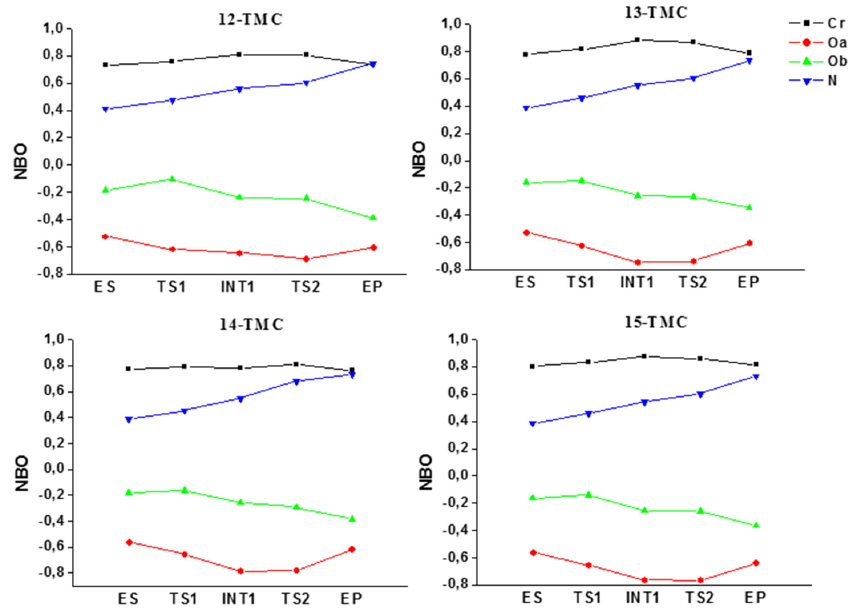
Figure 6. NBO charges in | e | for the atoms for every stationary point along the studied PESs (potential energy